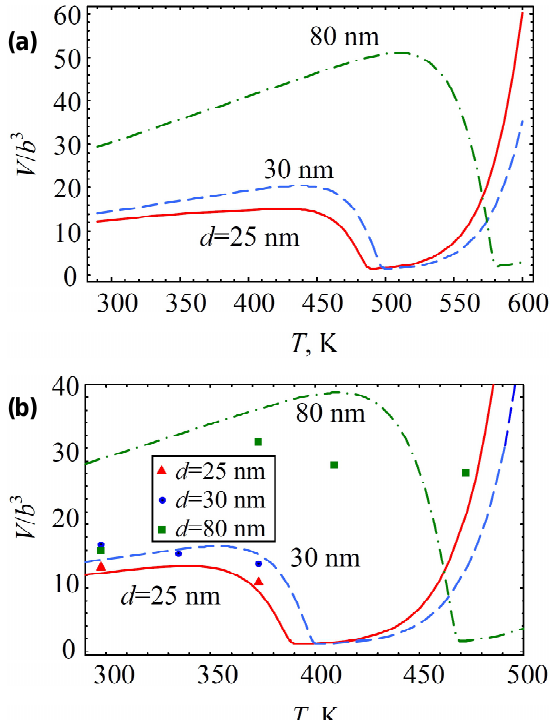
Fig. 7. Normalized activation volume of nanocrystalline Ni vs temperature, for various val- ues of Ni grain size d . Figures (a) and (b) corre- spond to the two different values of the activation energy Q of grain boundary self-diffusion of nanocrystalline Ni: (a) Q = 123 kJ/mol and (b) Q = 101 kJ/mol. The experimental points shown in (b) are taken from [21] based on the strain rate sensi- tivity measurements of